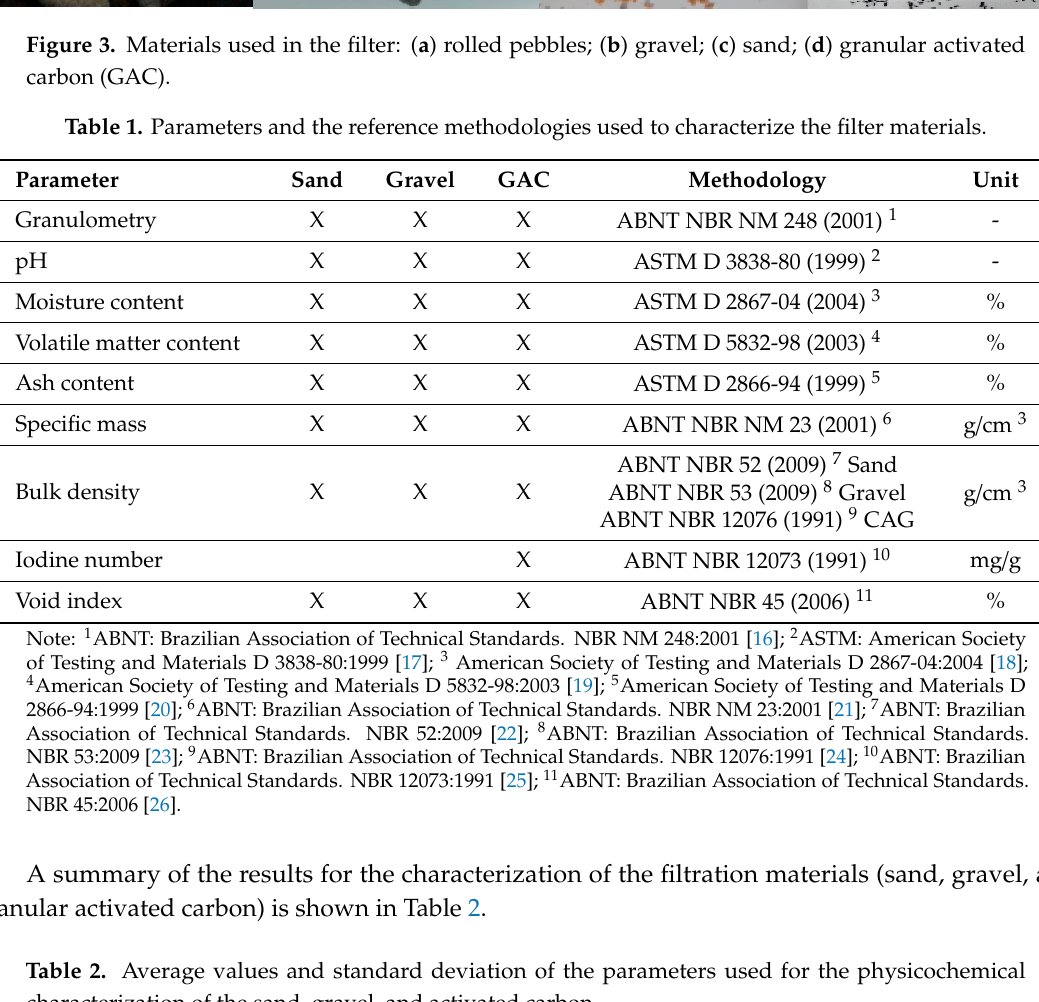
Table 2. Average values and standard deviation of the parameters used for the physicochemical characterization of the sand, gravel, and activated